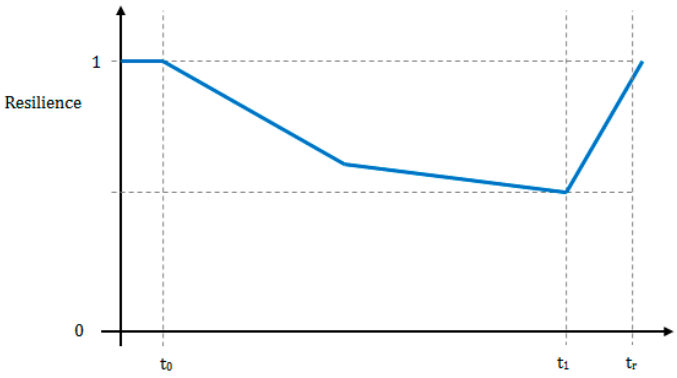
Figure 8. Resilience curve corresponding to a static performance measure—Option 2.